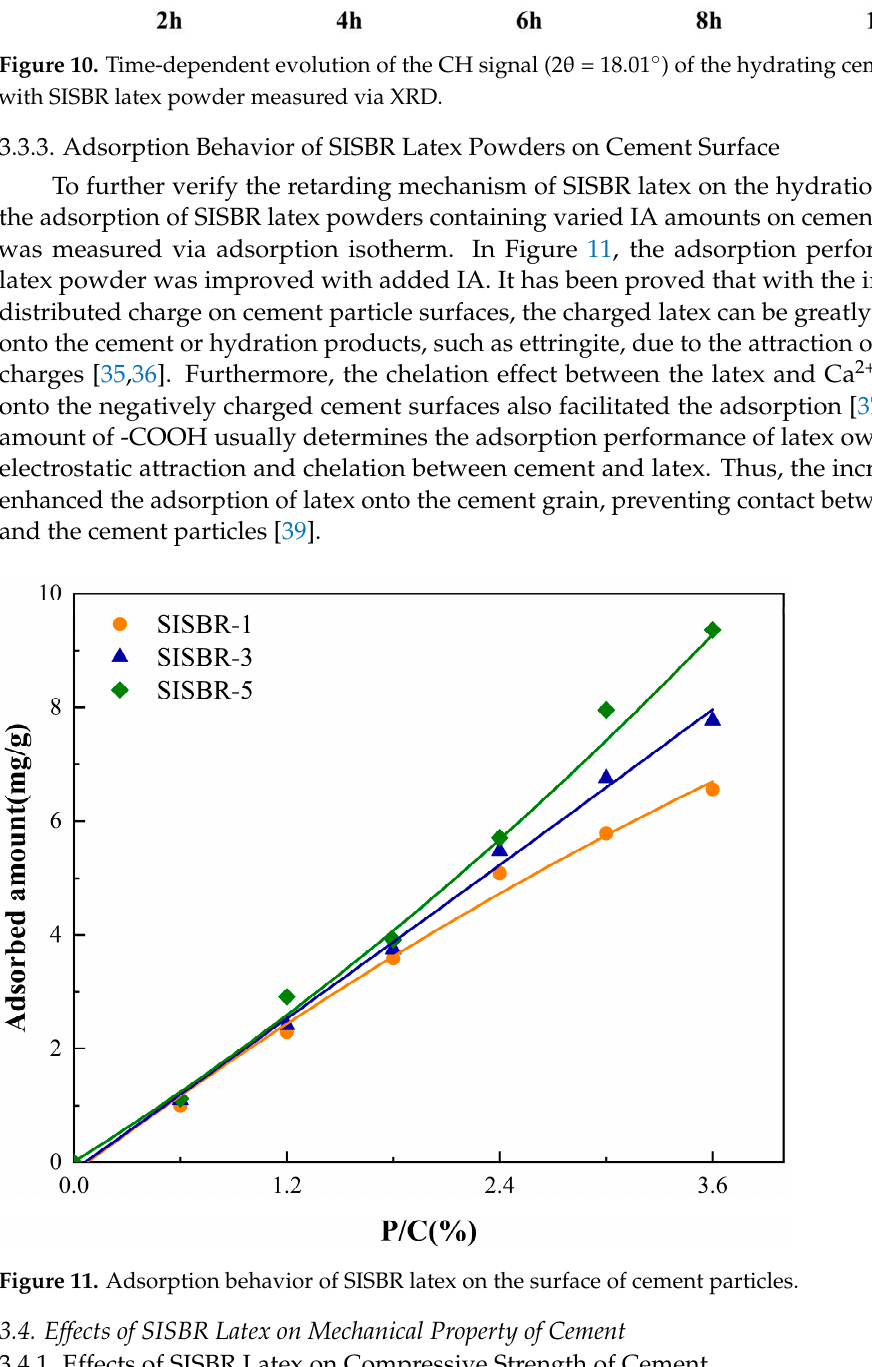
Figure 11. Adsorption behavior of SISBR latex on the surface of cement